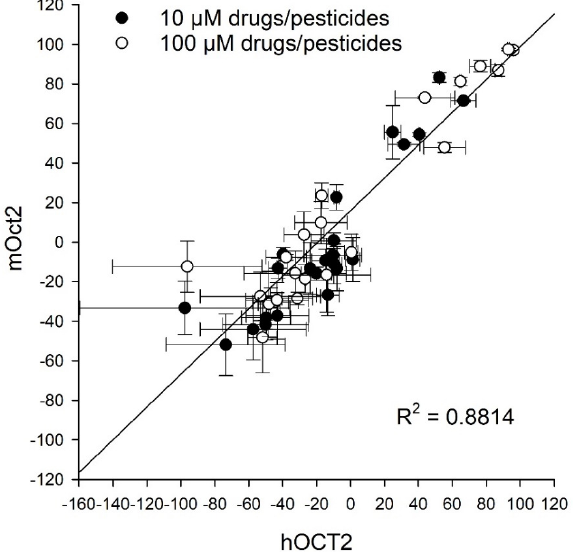
Figure 4. Correlation analysis between inhibitory effects of hOCT2- and mOct2-mediated transport of metformin. A correlation coefficient (R 2 ) of 0.88 indicates a good correlation between species. Data points represent mean and average deviation of two independent experiments. Mean values in detail are presented in Tables 1 and 2. Therefore, an IC 50 value for both compounds was determined. Concentration ‐ de ‐ pendent inhibition of hOCT2 ‐ and mOct2 ‐ mediated metformin transport by elacridar re ‐ sulted in IC 50 values of 20 ± 11 μ M and 1.9 ± 0.2 μ M, respectively (Figure 5A).